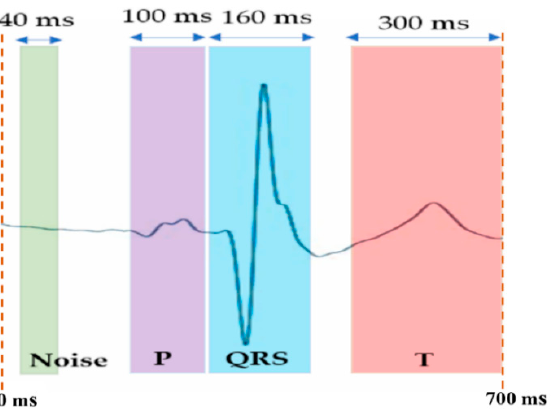
Figure 2. Noise and signal windows in the SAECG 700 ms frame (locked with respect the SFP point at 320 ms of the frame) for QRS signal-to-noise ratio (SNR), P/QRS ratio (PqrsR) and T/QRS ratio (PqrsR) analysis.